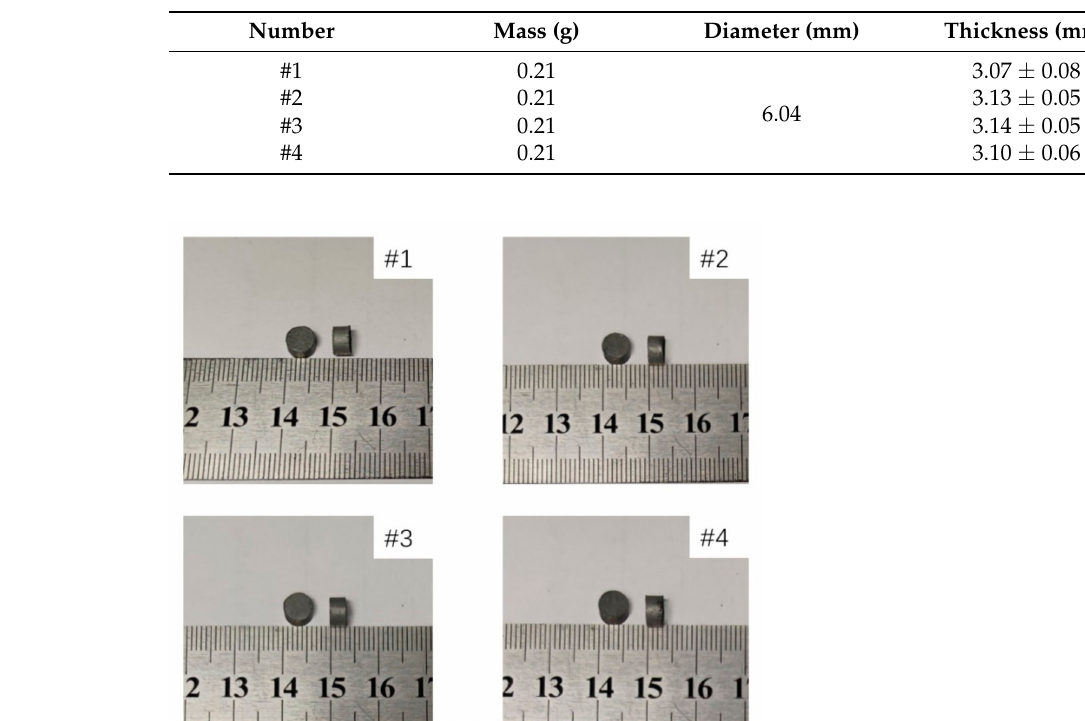
Table 3. Mass and size of four specimens.